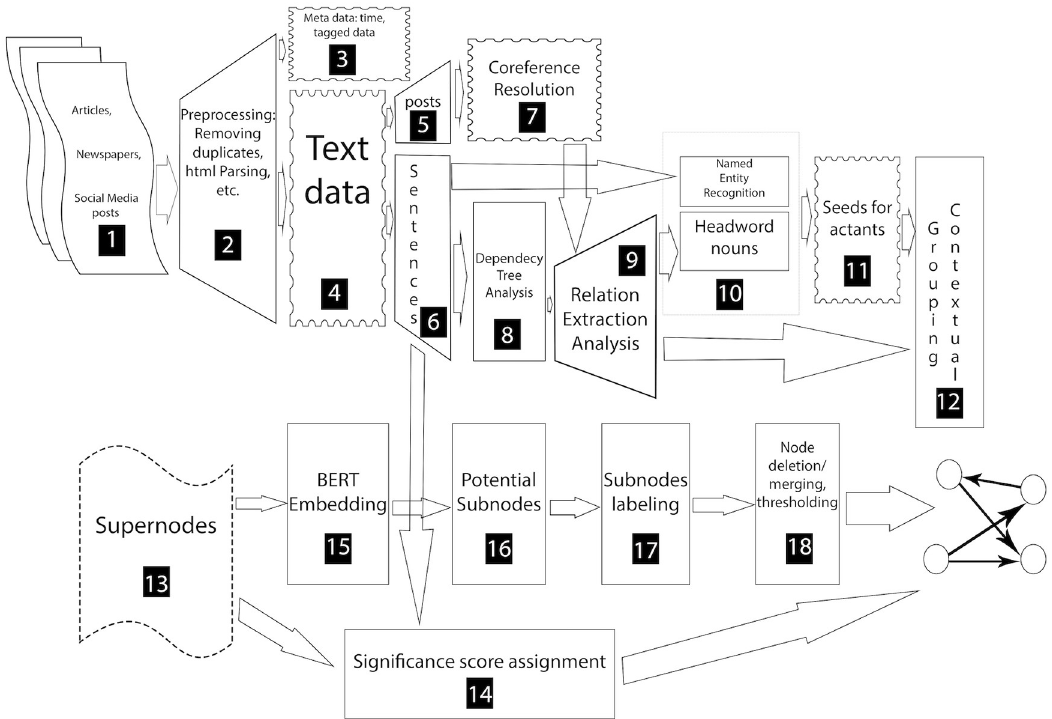
Fig 3. Representation of the narrative framework discovery pipeline. Most of these numbered blocks are described briefly in the main paper and in more detail in the S1 File.